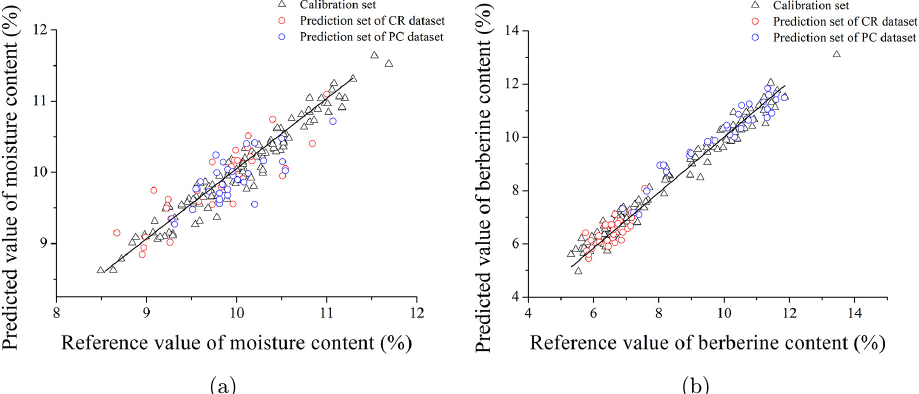
Fig. 10. Correlation diagram between NIRS predicted values and reference values of global model. (a) Moisture content and (b) Berberine